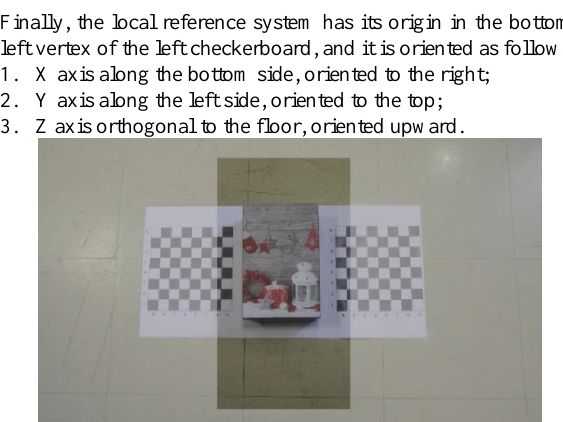
Figure 4. Analyzed portion for orthophoto reconstruction.